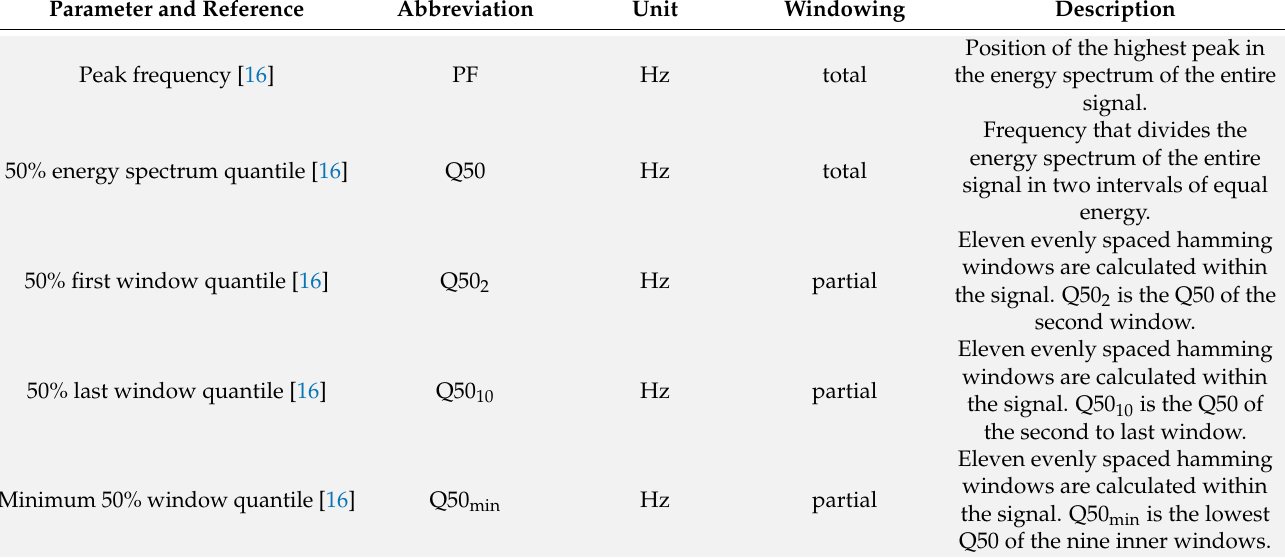
Table 2. Name, reference, units, general type of windowing, and a brief description of each investigated parameter. Parameter and